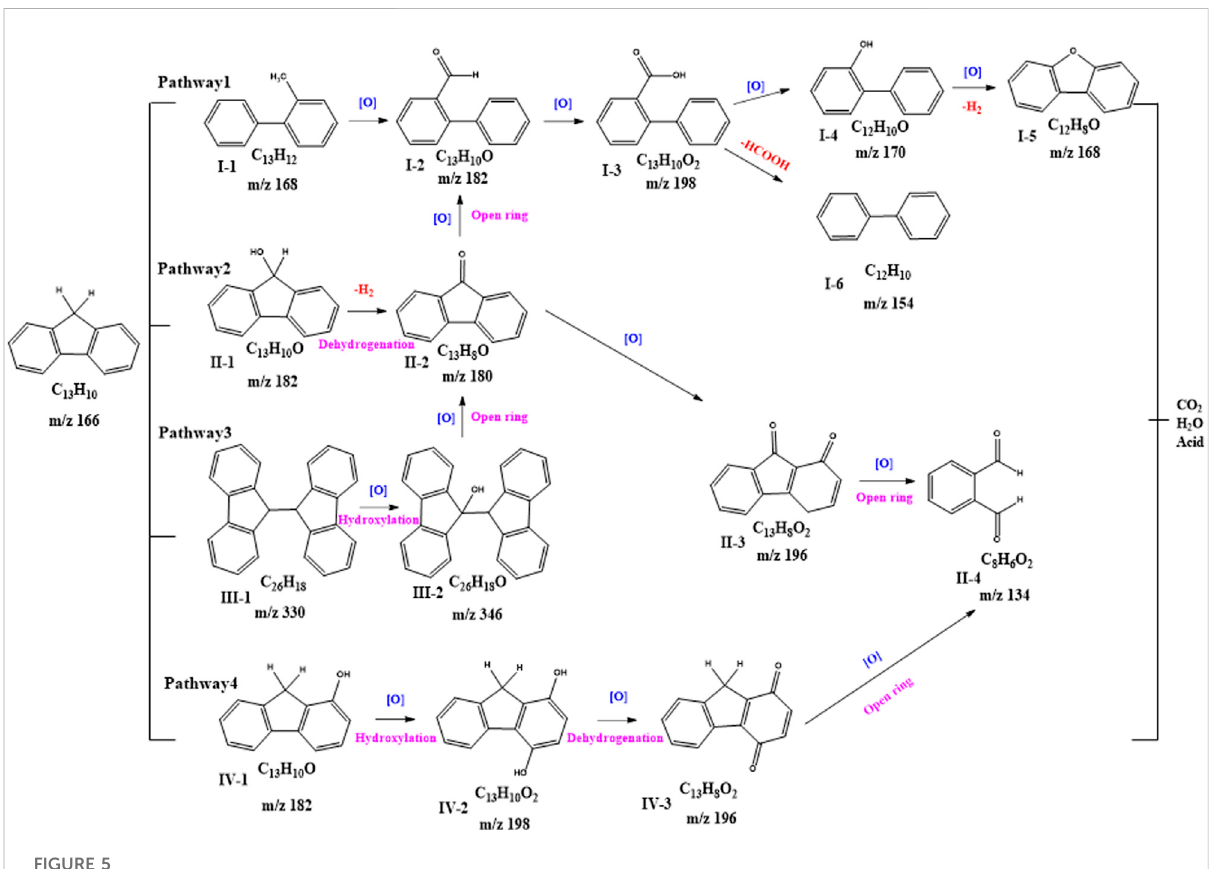
FIGURE 5 Proposed FLU degradation pathways in HA/Fe ( Ⅱ )/PS